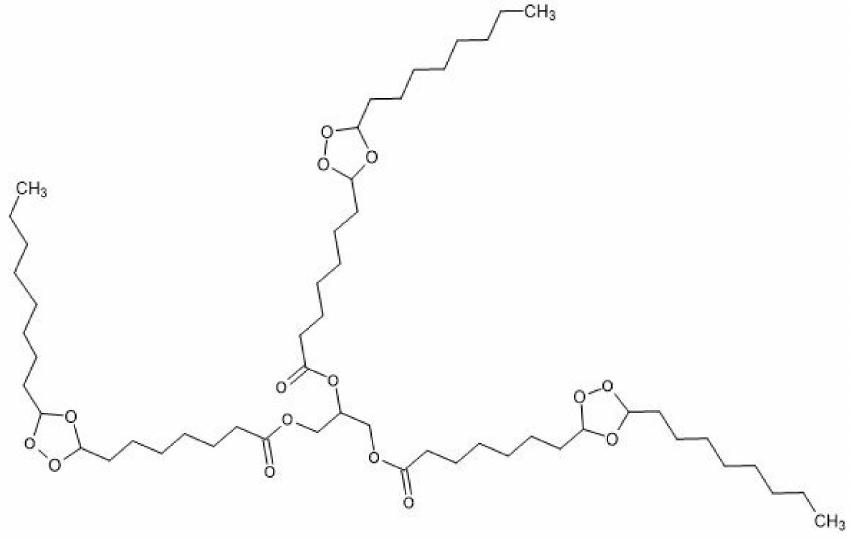
Figure 1. Chemical structure of glycero-(9,10-trioxolane)-trioleate (ozonide of oleic acid triglyc- eride,